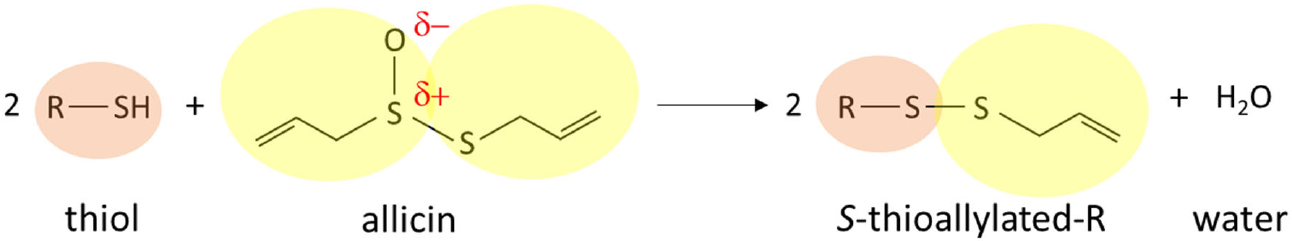
Scheme 2. Reaction of allicin with thiols. Two mol of reduced glutathione, other low molecular weight thiol, or accessible cysteine thiols in proteins (R—SH), can react with one mol of allicin to yield two mol of S ‐ thioallylated